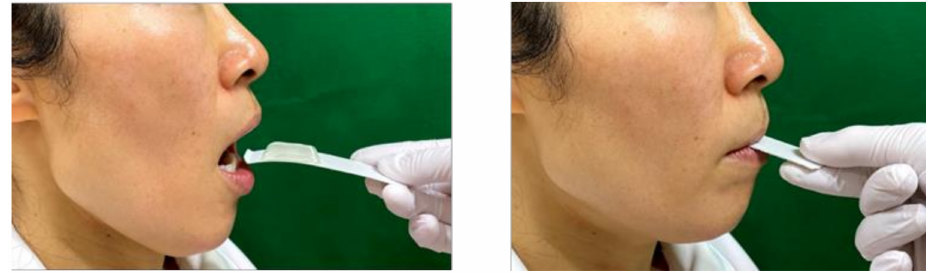
Figure 2. Tongue crush